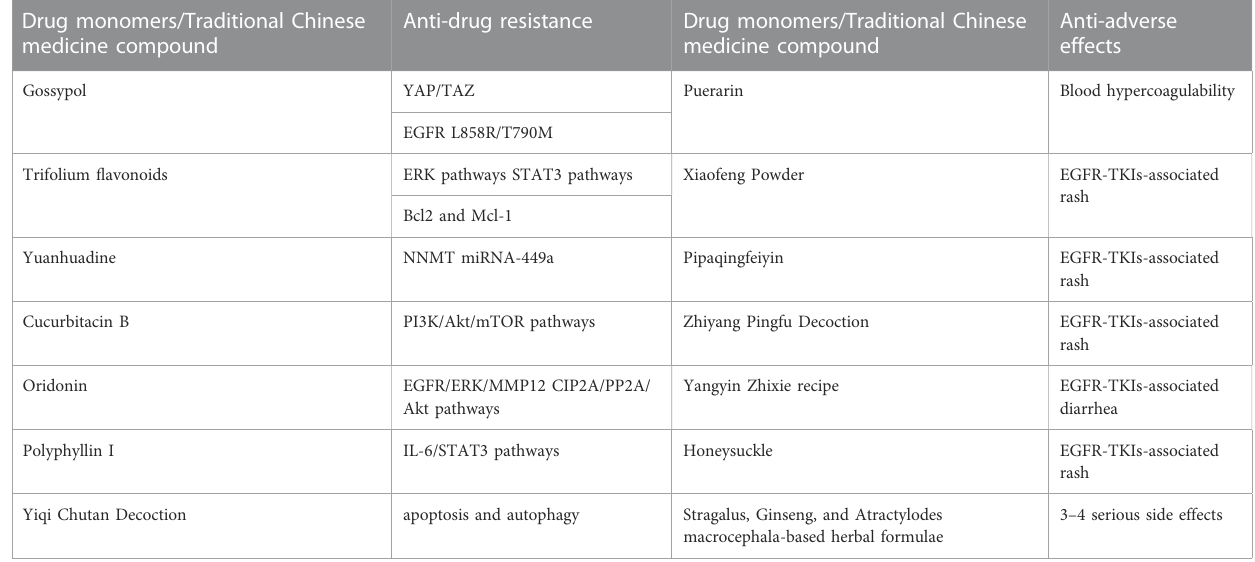
TABLE 2 The potential role of herbs and active compounds in overcoming drug resistance and adverse effects of EGFR-TKIs. Drug monomers/Traditional Chinese medicine